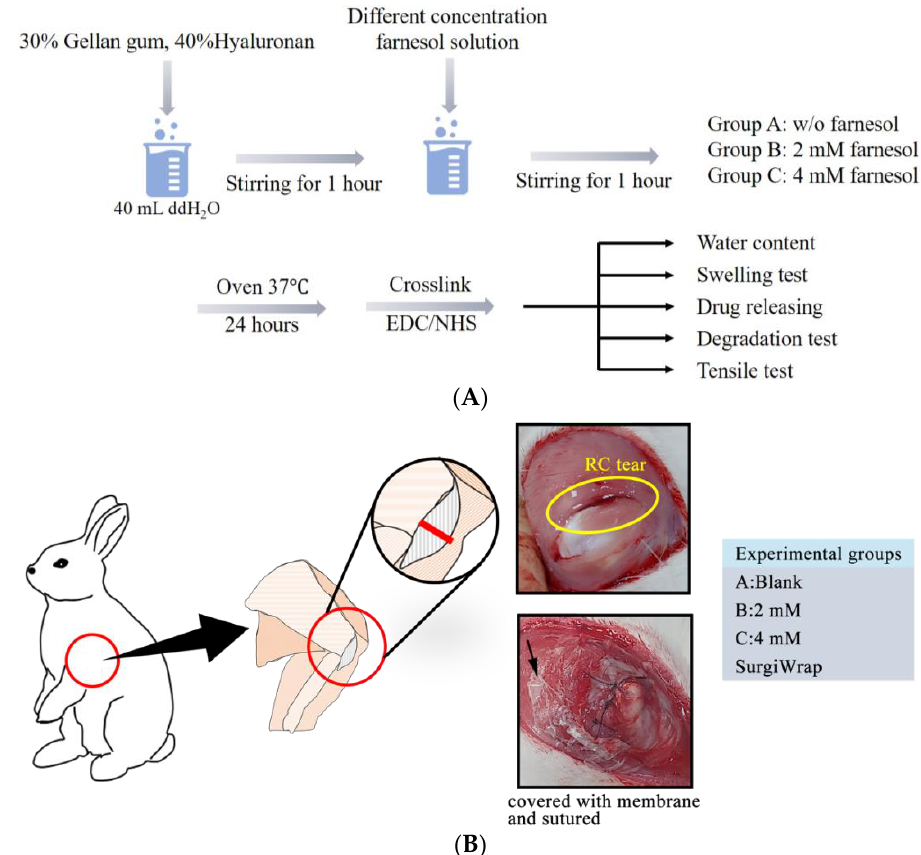
Figure 1. ( A ) Schematic of GHF hydrogel membrane preparation and characterization; ( B ) experimental designs of in vivo studies. A full-thickness RC tear was inflicted on the front limb of each rabbit and then closed using a 3-0 Prolene suture. Subsequently, the tear was either covered with or without the hydrogel membrane. The comparison group comprised rabbits whose RC tears were covered with a SurgiWrap membrane.